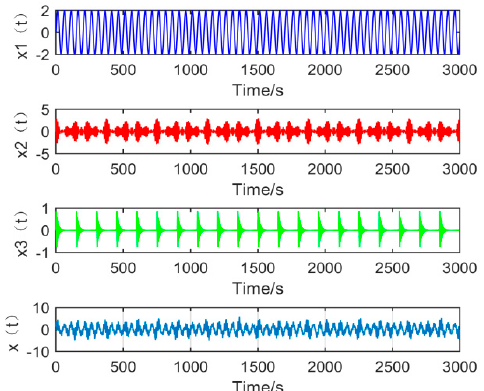
Figure 6. The time domain waveform of each component signal and simulation signal.